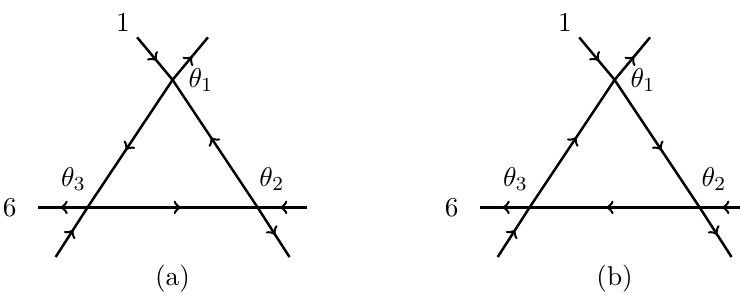
Figure 2. The two six-point diagrams correspond to different ways of arranging arrow flow of the internal lines. Here and throughout this paper we only label the first and last external